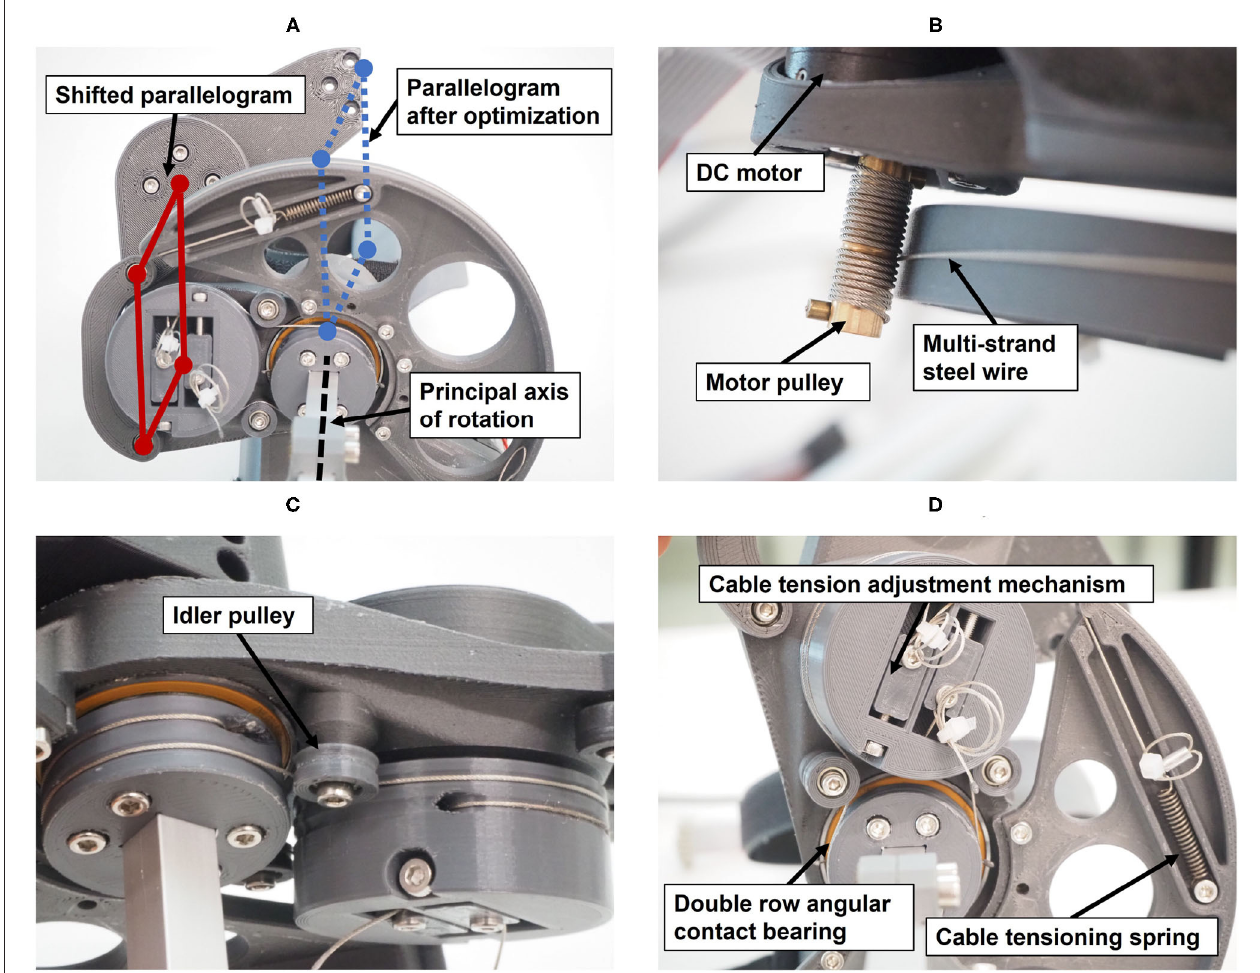
FIGURE 10 | Technical details of the prototype: (A) View from below showing the shifted parallelogram. (B) Actuation of the principal axis of rotation through a capstan transmission. (C) Actuation of the parallelogram, including idler pulley for cable guidance. (D) Cable tensioning mechanisms.